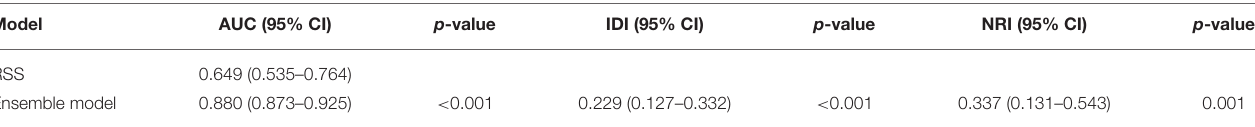
TABLE 4 | Comparison of performance for cardiovascular mortality prediction between the RSS and the model. Model AUC (95%